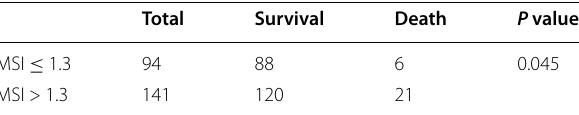
Table 3 MSI on admission with statistical significance in predicting outcome